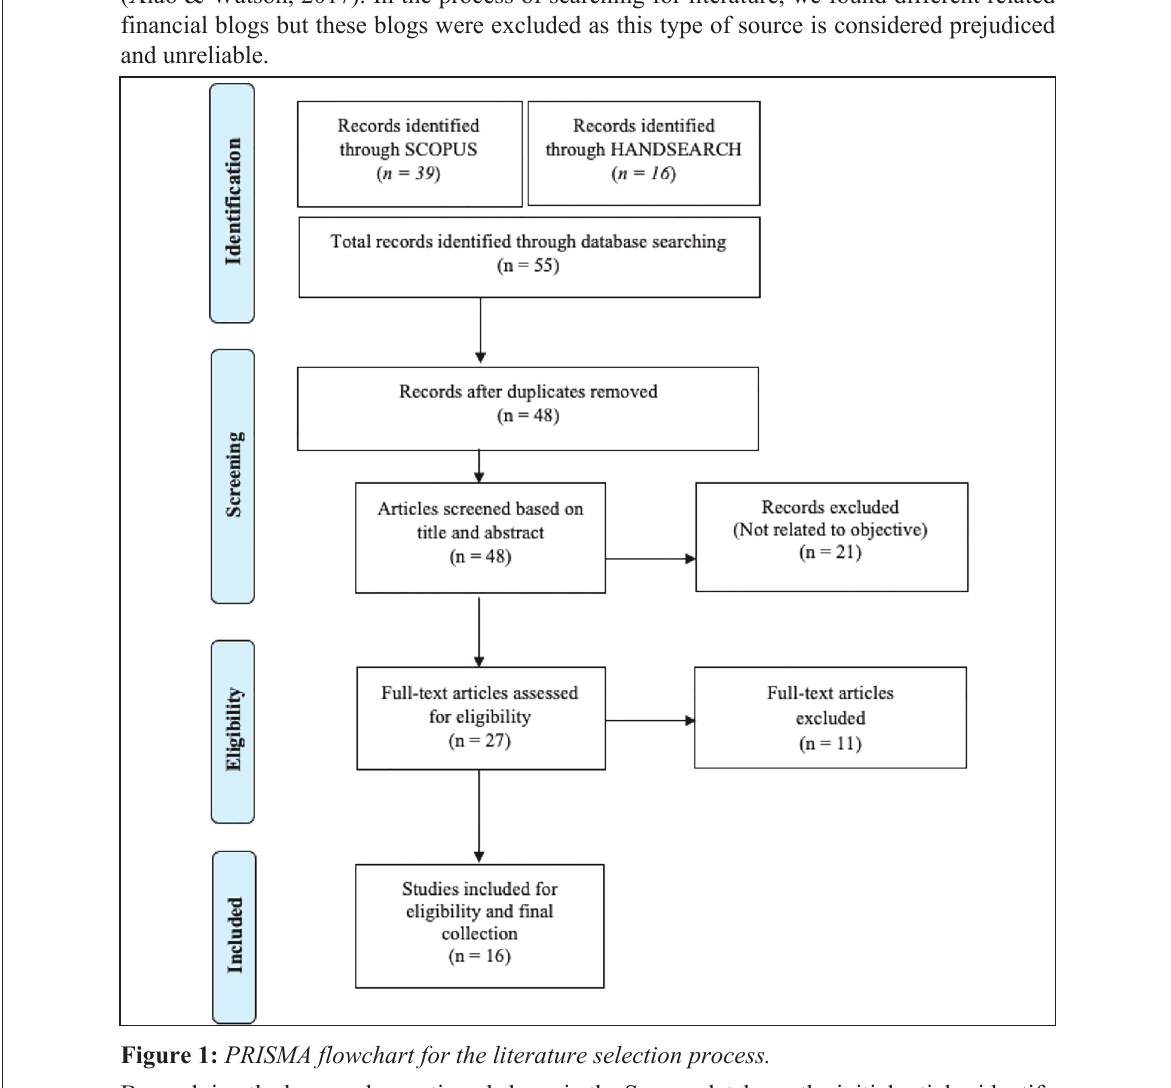
Figure 1: PRISMA flowchart for the literature selection